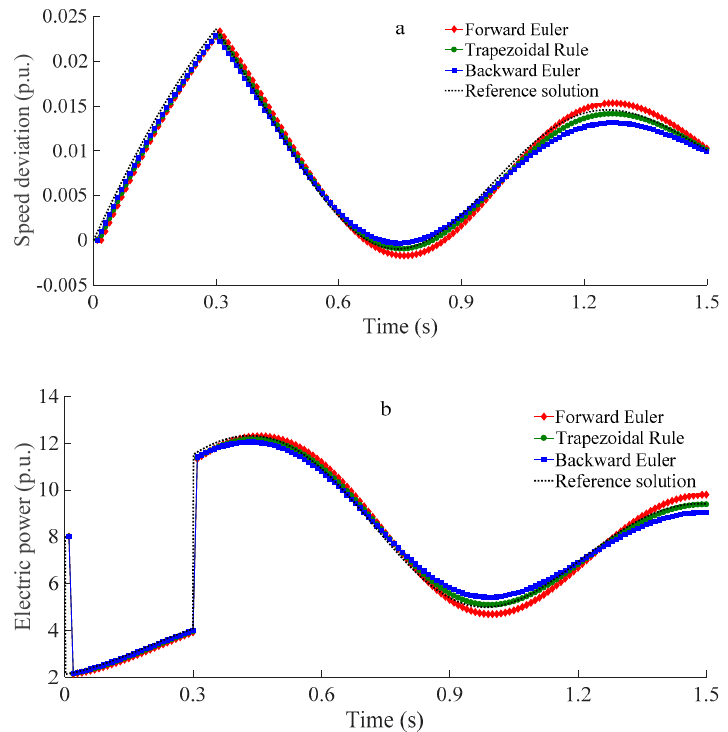
Figure 6. Two variables when a short circuit is applied at bus 3 and the integration time step is 0.01 s: ( a ) Rotor speed deviation at the generator at bus 30 ( b ) Electric power output at the generator at bus 30.